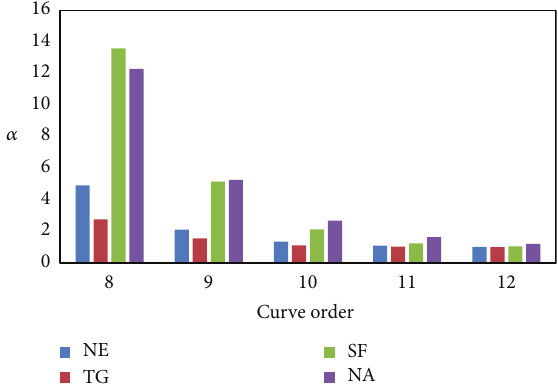
Figure 5: Average number of POIs versus curve order.